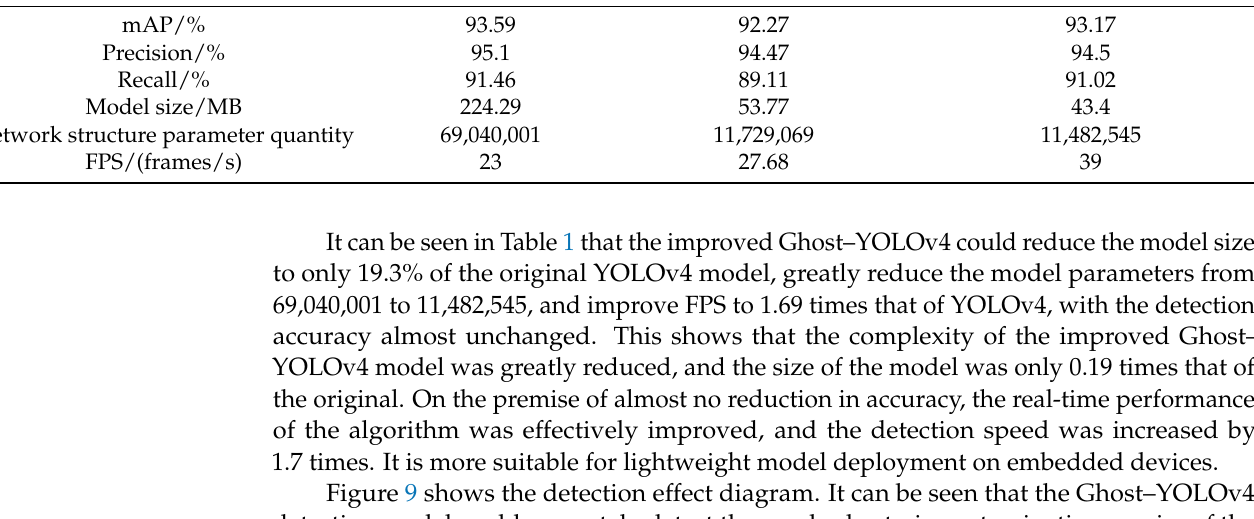
Table 1. Comparison of performance indexes of the model.